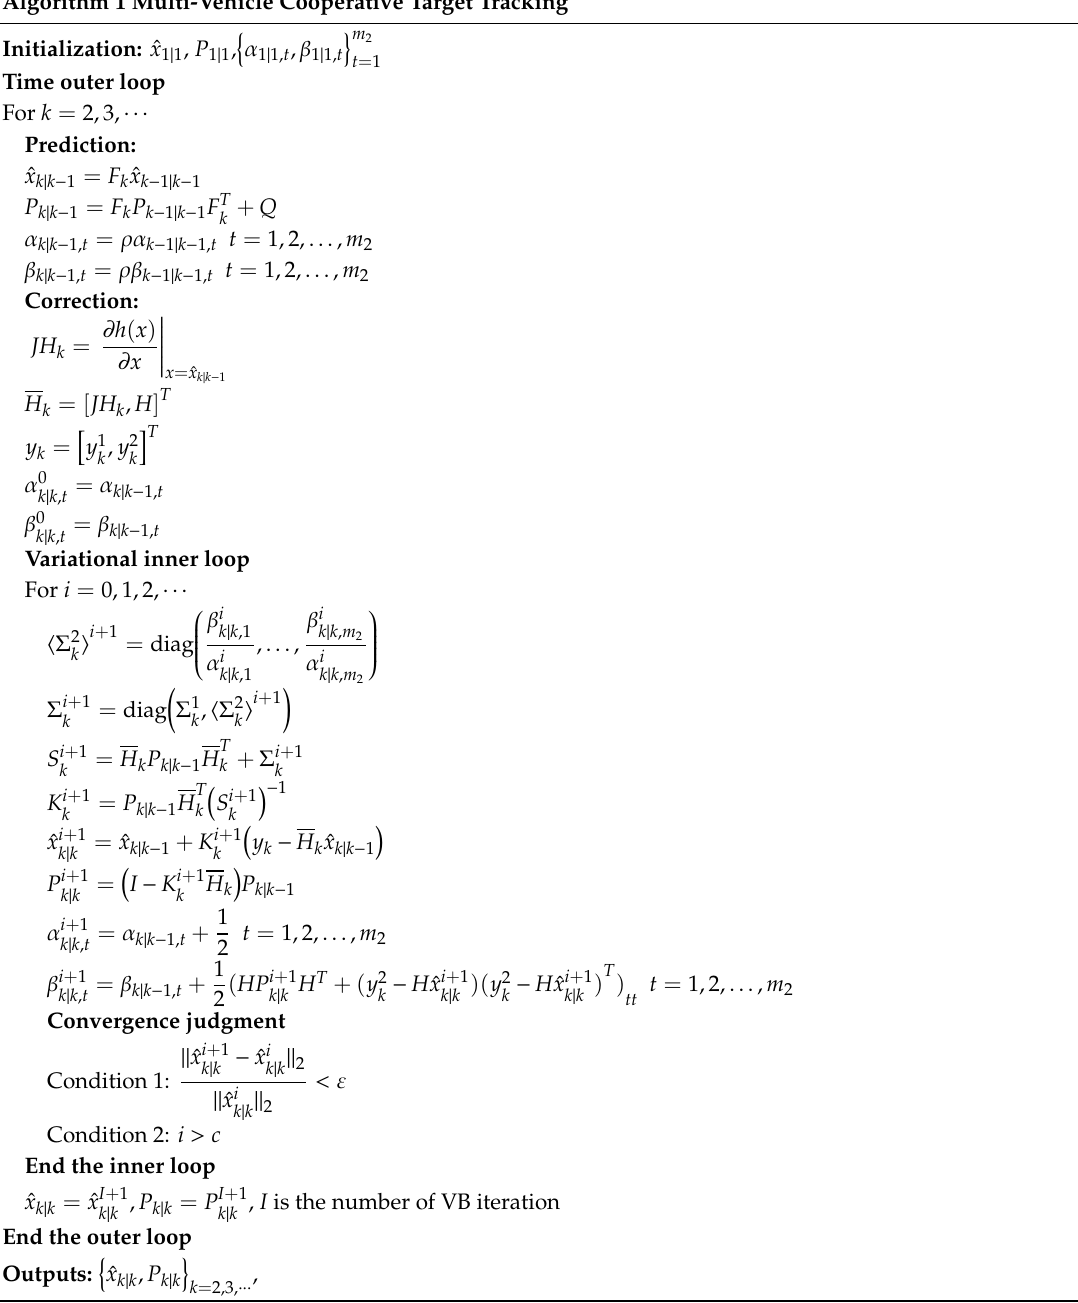
Algorithm 1 Multi-Vehicle Cooperative Target